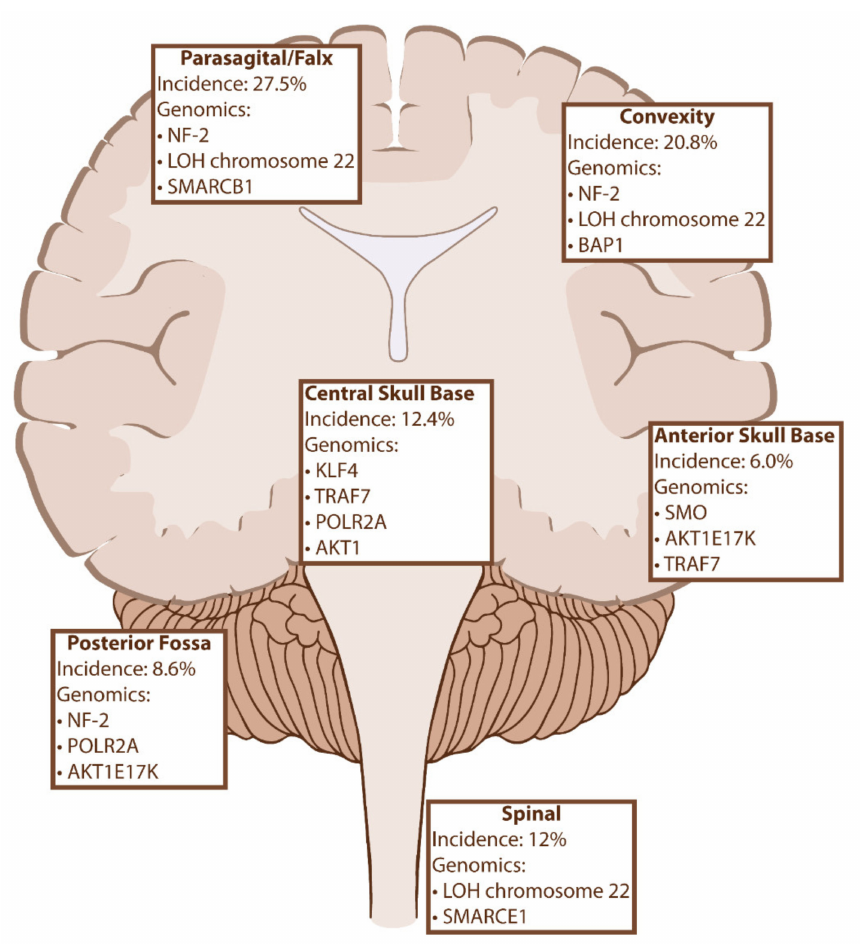
Figure 2. Meningioma location and related genomic markers with incidences [51,52]. Abbrevi- ations: LOH, Loss of Heterozygosity; NF-2, neurofibromatosis 2; TRAF7, Tumor necrosis factor receptor-associated factor 7; KLF4, Kruppel-like factor 4; AKT1, v-Akt murine thymoma viral onco- gene homolog 1; SMO, Smoothened, frizzled class G protein-coupled receptor; POLR2A, enzyme RNA polymerase II, subunit A; SMARCB1, SWI/SNF-Related, matrix-associated, actin-dependent regulator of chromatin subfamily B member 1; SMARCE1, SWI/SNF Related, matrix-associated, actin-dependent regulator of chromatin subfamily E member